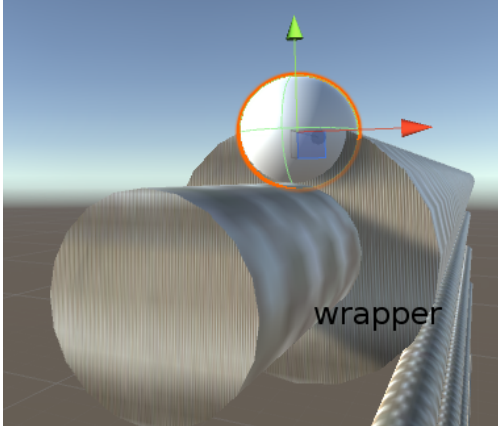
Figure 4. Mismatching positions of the visual and haptic collision point. Wrapping with a touchable